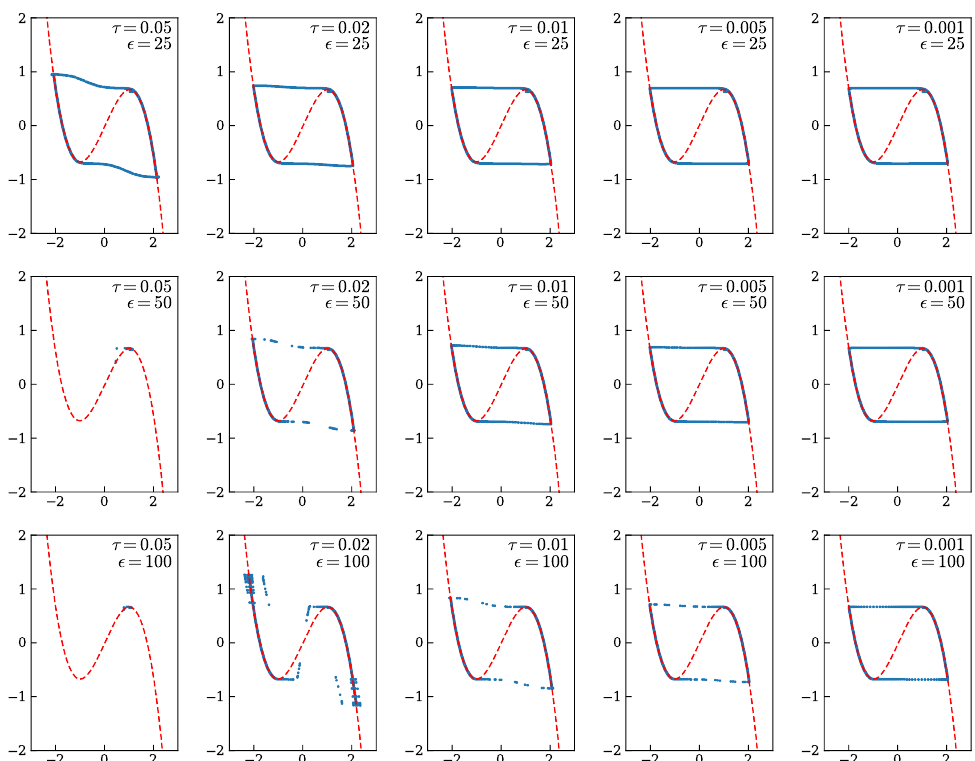
Figure 7. Orbits for the stiff van der Pol oscillator obtained with the variational ap- proach of Section 3.4 for different values of the coupling (cid:101) and of the time step τ after the Liénard transformation: With (cid:101) ∈ { 25,50,100 } increasing from top to bottom and τ ∈ { 10 − 2 ,5 × 10 − 3 ,10 − 3 ,5 × 10 − 4 ,10 − 4 } decreasing from left to